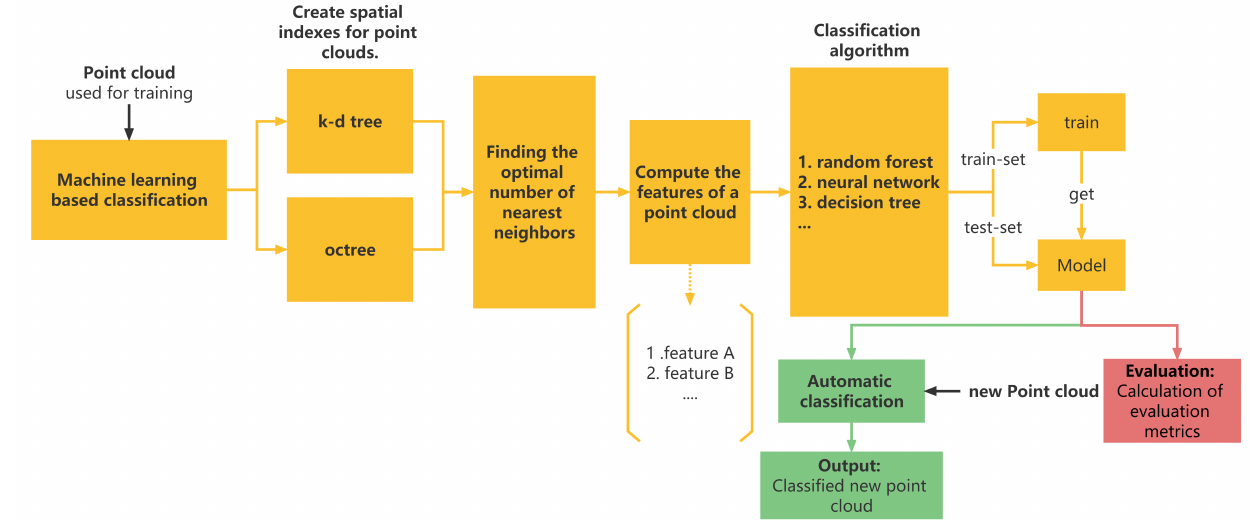
Figure 2. Typical workflow of classification